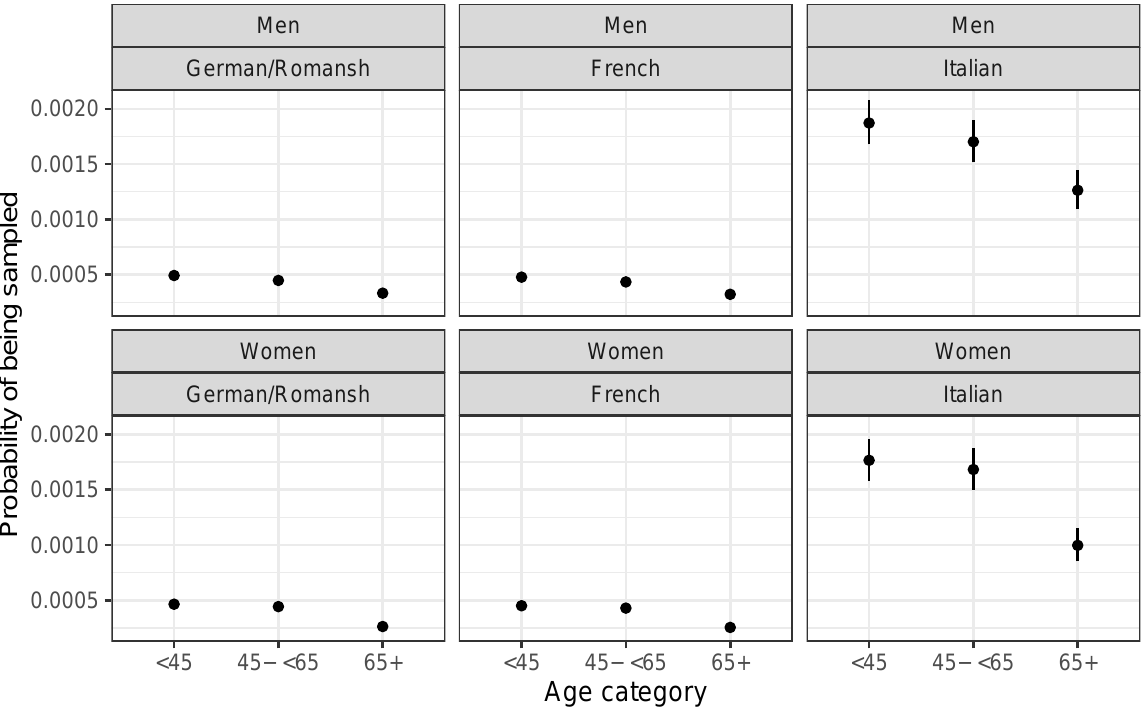
Points indicate posterior mean estimates. Lines indicate 95% posterior credible